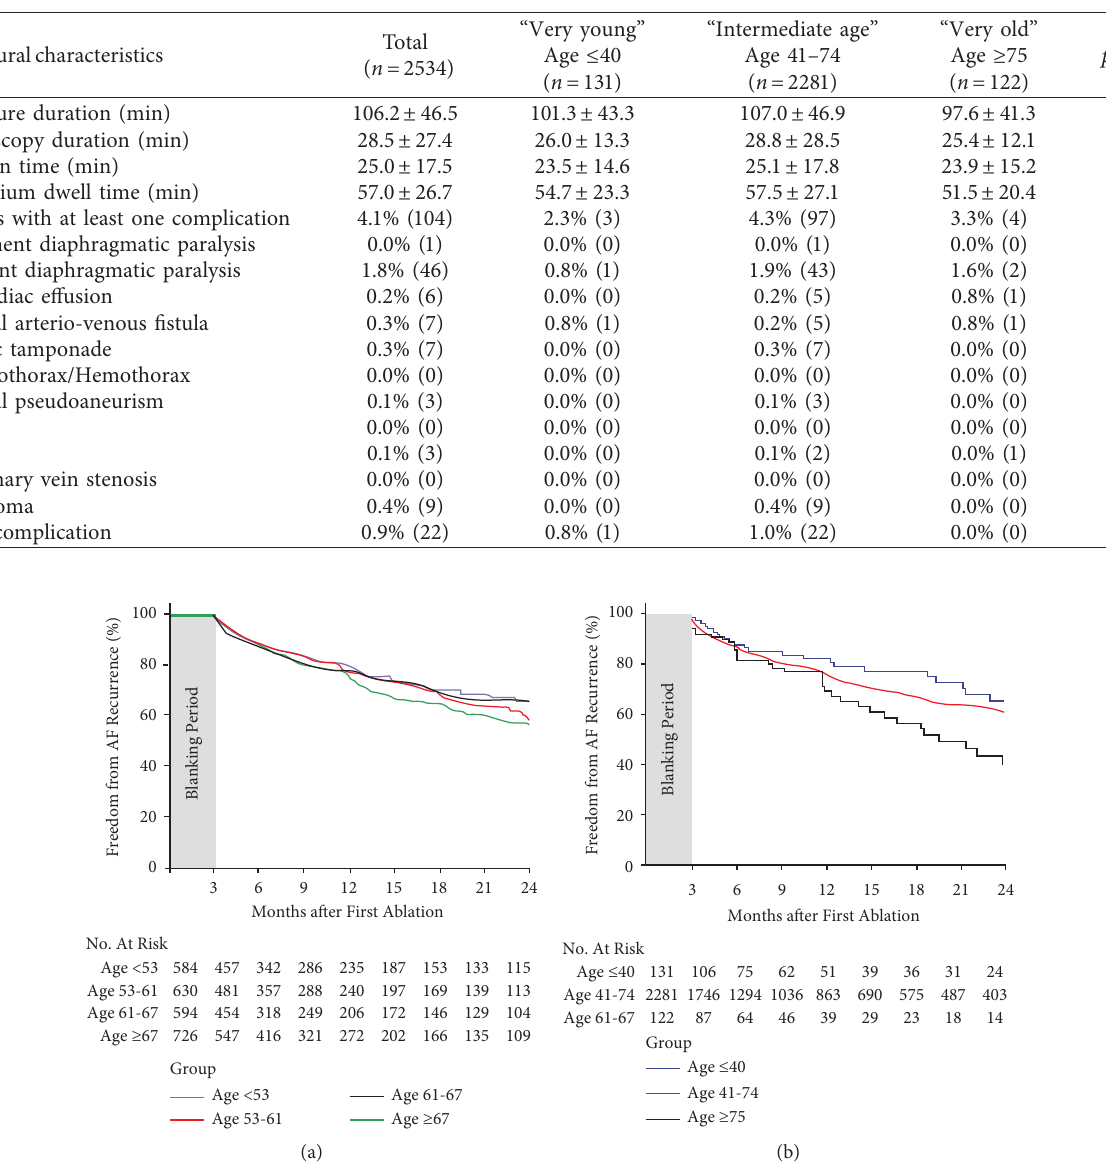
Table 3: Procedural and safety characteristics ( N � 2534) by three age groups.